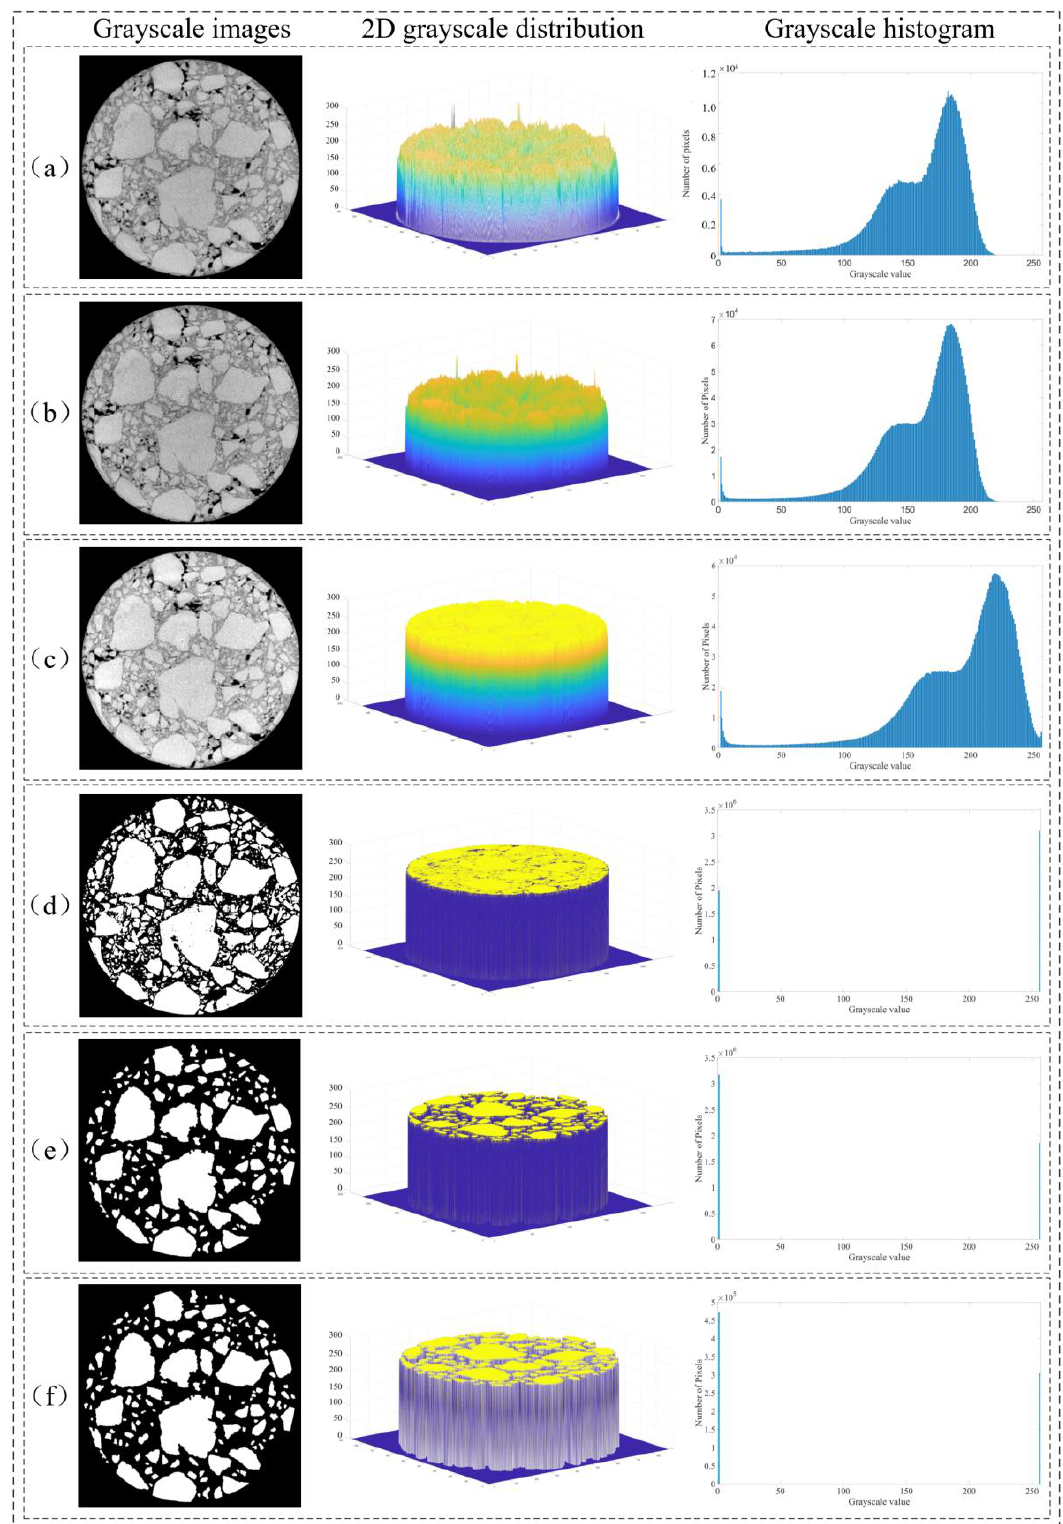
Figure 9. Changes in the grayscale of CT slice images during CT image preprocessing and 2D image segmentation stages: ( a ) after uniform grayscale; ( b ) after increasing image pixel density; ( c ) after the filtering process; ( d ) after OTSU segmentation; ( e ) after watershed segmentation; ( f ) after restoring image pixel